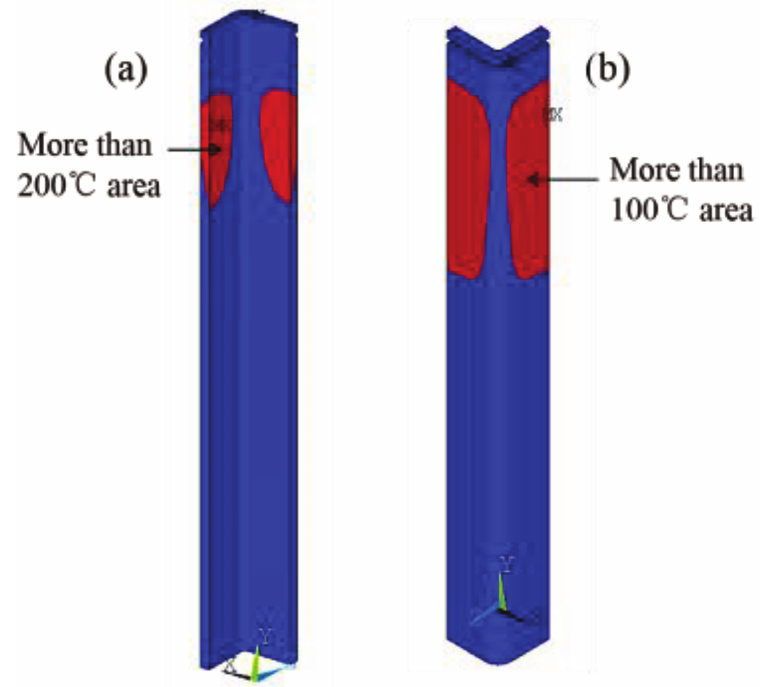
Figure 9: High-temperature regions of mold wall with 0.5-mm-thick scale on (a) hot face and (b) cold